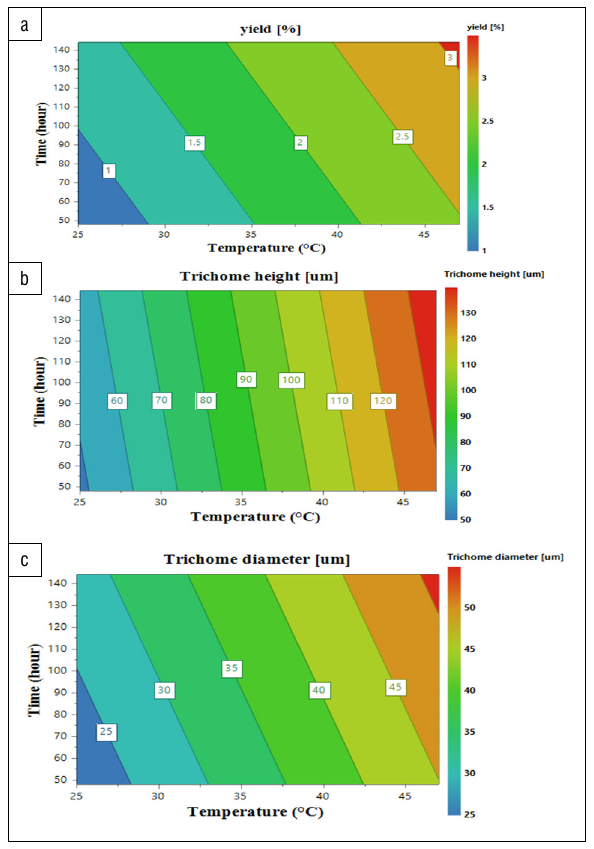
Figure 2: Contour plots showing the direct and interaction impacts of temperature and time on (a) essential oil yield, (b) trichrome height, and (c) trichome diameter of Lippia javanica